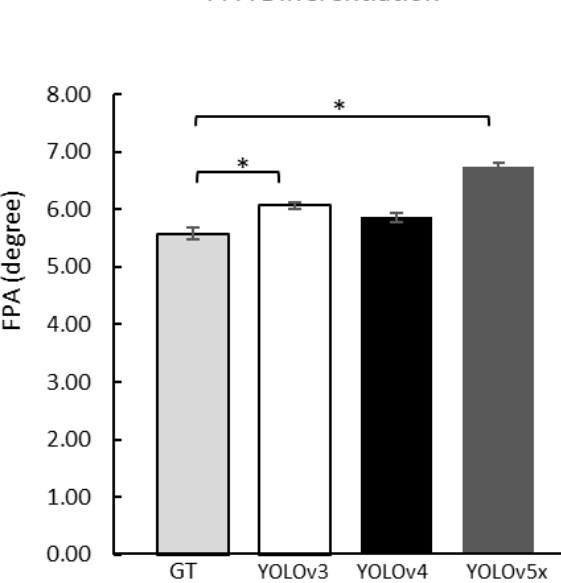
Figure 6. FPA comparison between GT with YOLOv3, v4, and v5x. GT, Ground-truth; *, a significant difference ( p < 0.01).